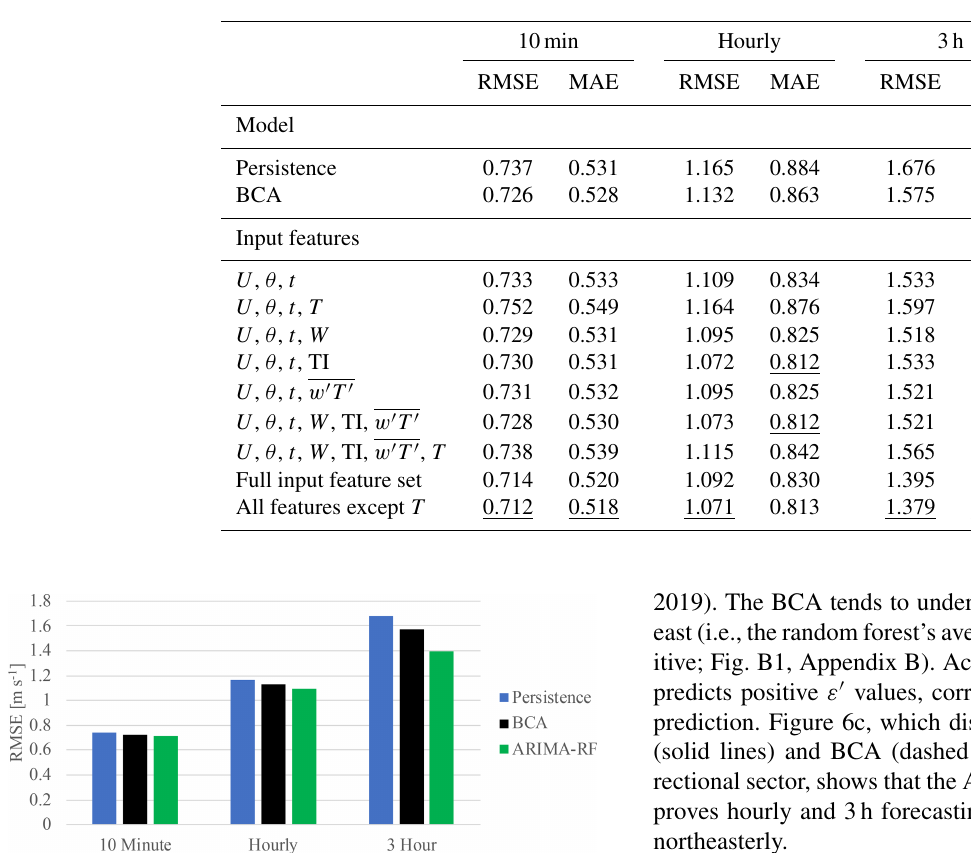
Table 1. RMSE and MAE (ms − 1 ) obtained by the persistence, BCA, and ARIMA–RF models when utilizing select input feature combina- tions. The final two rows show the testing results when utilizing the full input feature set and the full feature set except T . Underlined values show the best performance from each column.